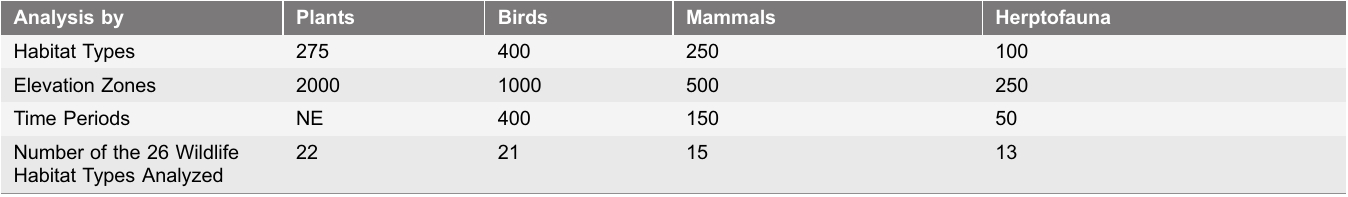
Table 3. Rarefaction threshold cutoff values sample sizes for habitat types, elevation zones, and time periods for plants, birds, mammals, and herptofauna.